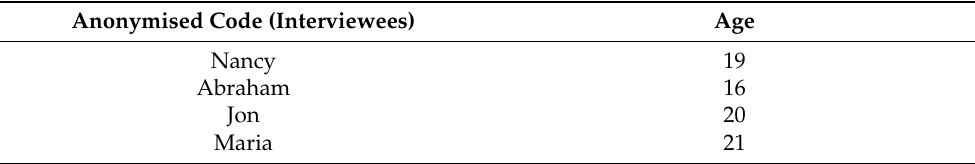
Table 2. Profiles of the interviewees through the Communicative